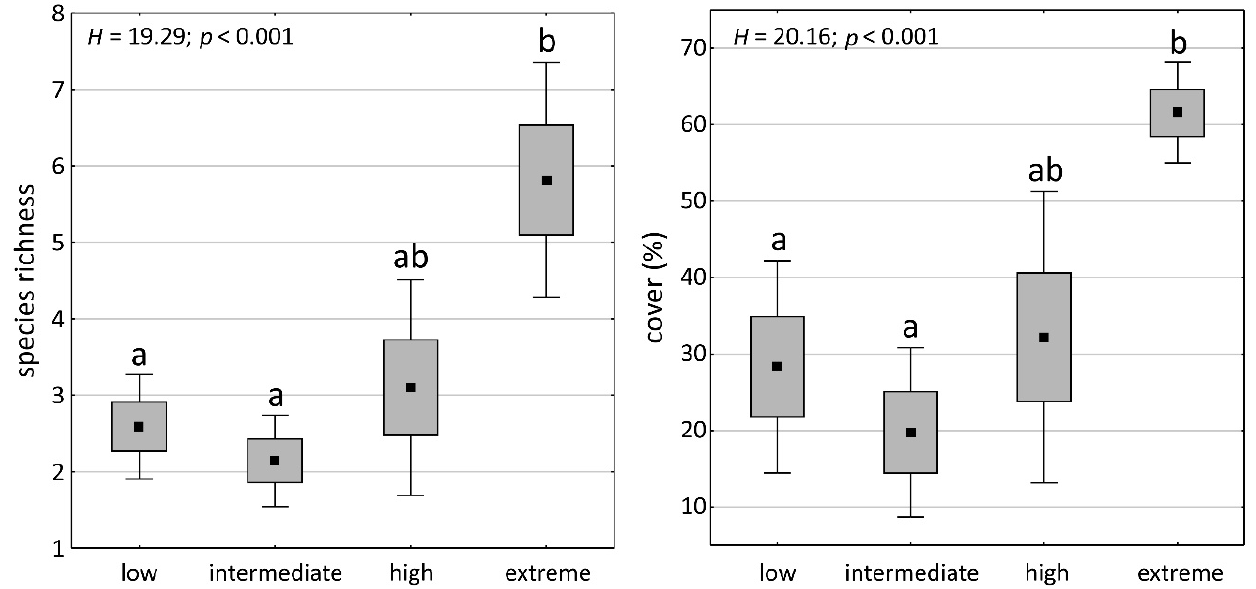
Figure 3. Box-and-whisker plots of bryophyte species richness and cover in particular soil condition classes. The points indicate the means, boxes indicate standard errors, and whiskers 95% confidence intervals. The results of Kruskal–Wallis test ( p < 0.05) are included: H and p -values. The letters denote the results of Dunn’s post hoc test; different letters indicate significant differences at the p < 0.05 level.